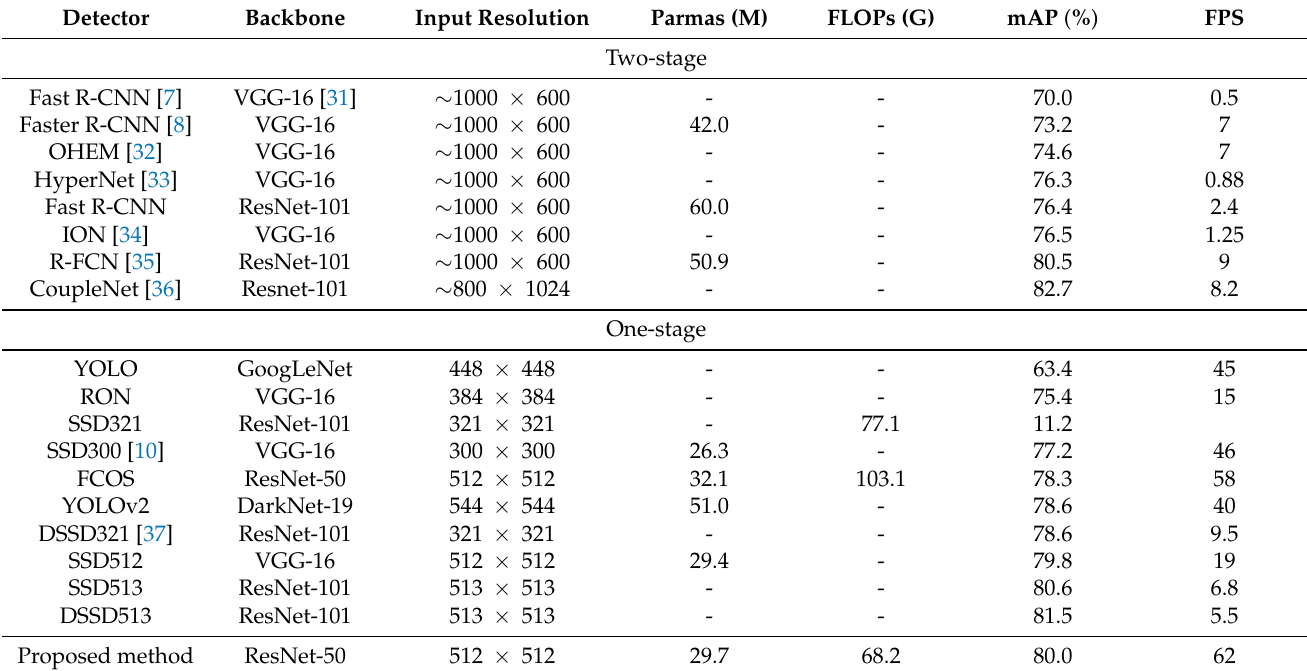
Table 3. Comparison of PASCAL VOC07 test dataset detection